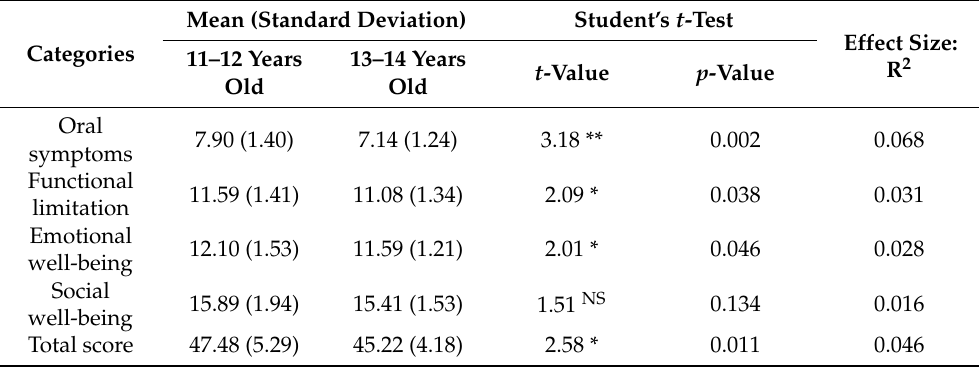
Table 4. Inferential analysis. Variables of the CPQ-Esp 11–14 questionnaire on OHRQoL according to age ( n =